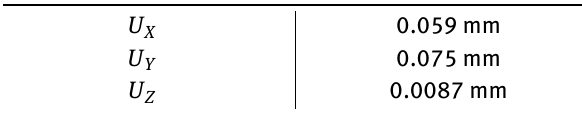
Table 4: Maximum Displacements of the Polar Expansions and Bases